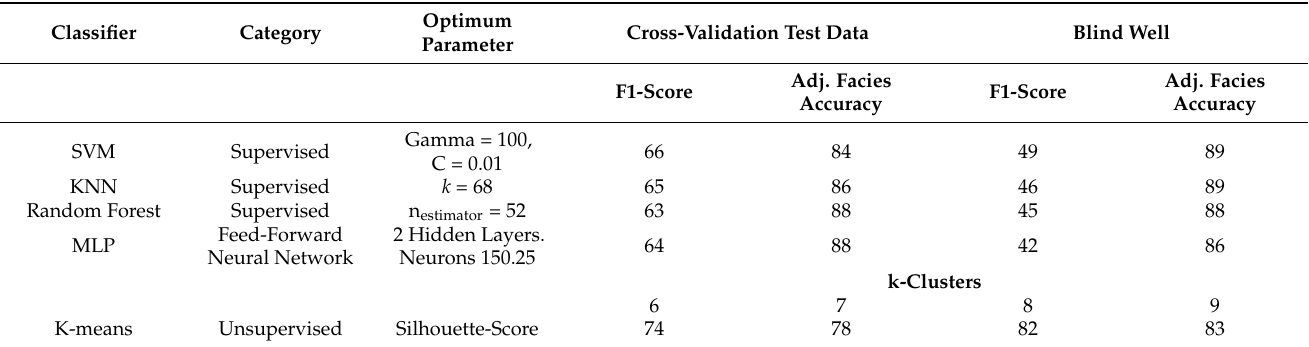
Table 2. Summary of the scores for different classifiers with optimum parameters. Results are presented in %. Reprinted with permission from [13], copyright Society of Petroleum Engineers (SPE), 2019.